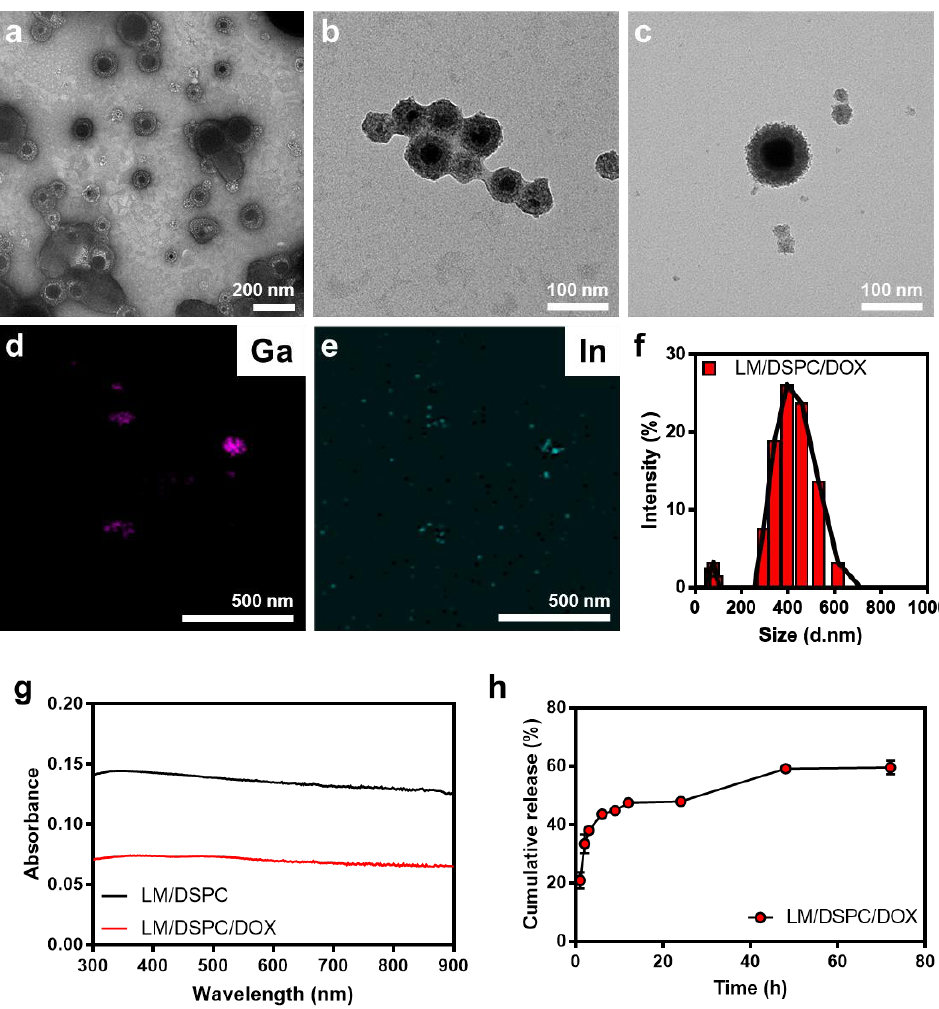
Figure 2. Characteristics of the LM/DSPC/DOX particles. ( a – c ) Morphology analysis of the LM/DSPC/DOX particles using transmission electron microscopy (TEM) and ( d , e ) energy dispersive X-ray spectroscopy (EDS) mapping. ( f ) Size distribution of the LM/DSPC/DOX particles. ( g ) UV spectroscopy of the LM/DSPC and LM/DSPC/DOX particles. ( h ) Cumulative doxorubicin release of the LM/DSPC/DOX particles.